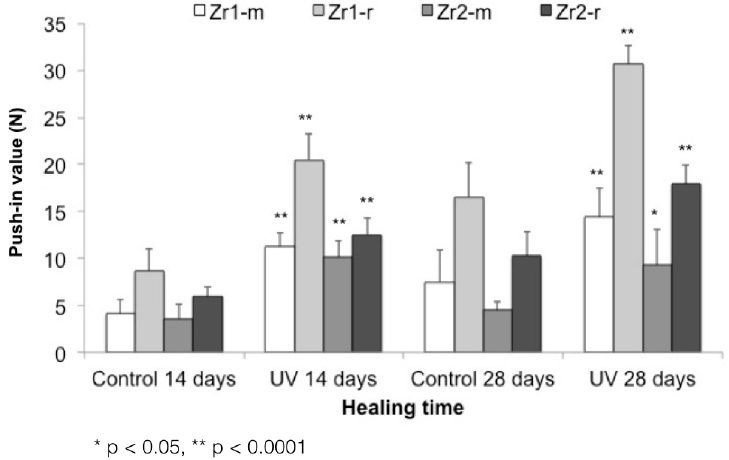
Figure 8. Push-in values around Zr1-m, Zr1-r, Zr2-m and Zr2-r before and after UV treatment.